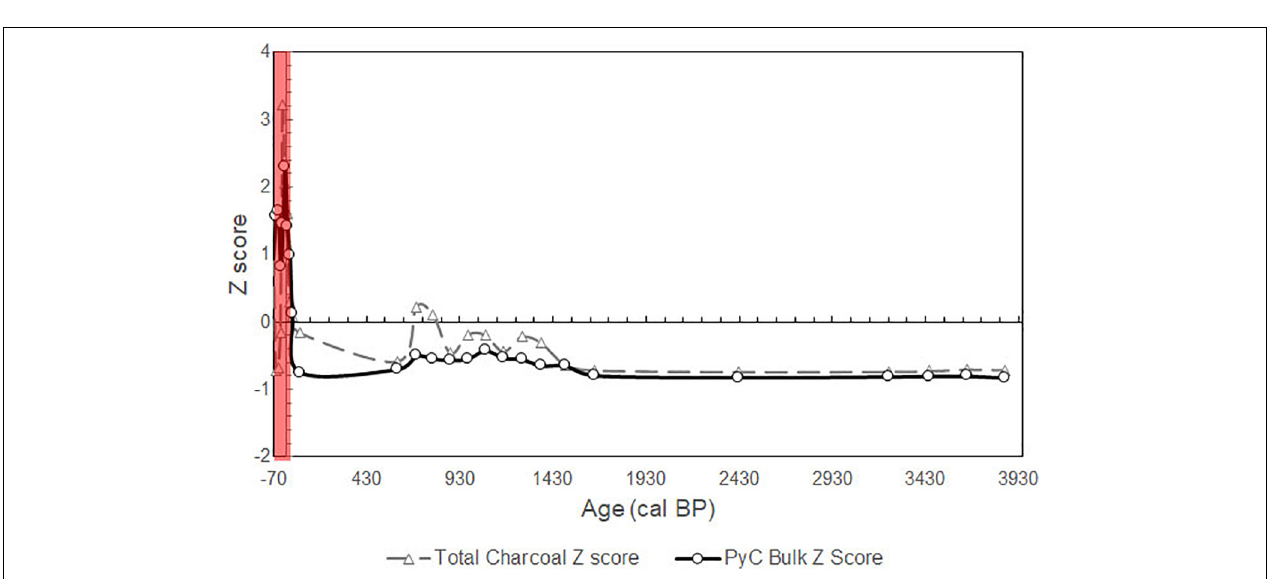
FIGURE 6 | Stratigraphic plot of data from Big Willum Swamp core BWIL2, plotted by age. Proxies plotted are Mo ratio (organic signal), charcoal fluxes by size fraction, charcoal elongate particle percentages, pyrogenic carbon fluxes by size fraction, pyrogenic carbon δ 13 C, and Z scores for total charcoal particles and bulk pyrogenic carbon.